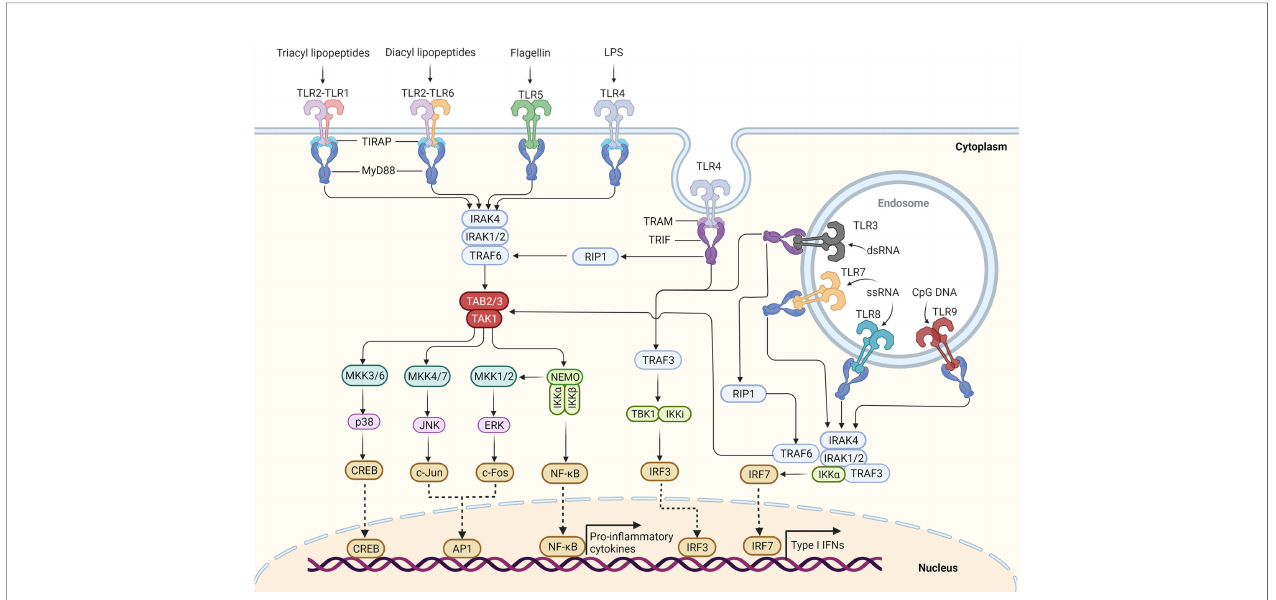
FIGURE 1 | TLR signaling pathway in innate immune cells. TLR5, TLR4, and the heterodimers of TLR2 – TLR1 or TLR2 – TLR6 prefer to recognize the membrane components of pathogens at the cell surface, whereas TLR3, TLR7 – TLR8, and TLR9 localize to the endosomes, where they recognize the nucleic acids from both the host and foreign microorganisms. TLR4 localizes at the plasma membrane, but it is endocytosed into endosomes upon activation. Upon binding to their respective ligands, TLR signaling is initiated by dimerization of receptors, leading to the engagement of TIR domains of TLRs with TIRAP and MyD88 (or directly interact with MyD88) or with TRAM and TRIF (or directly interact with TRIF). The TLR4 signaling switches from MyD88 to TRIF once TLR4 moves to the endosomes. Engagement of MyD88 recruits the downstream signaling molecules to form Myddosome, which is based on MyD88 and contains IRAK4 and IRAK1/2. IRAK1 further activates the E3 ubiquitin ligase-TRAF6 to synthesize the K63-linked polyubiquitin chains, leading to the recruitment and activation of the TAK1 complex. The activated TAK1 further phosphorylates and activates the canonical IKK complex, ultimately leading to the activation factor NF- k B. The activation of TAK1 also leads to the activation of MAPKs, including MKK4/7 and MKK3/6, which further activate JNK and p38, respectively. The activation of IKK b also leads to the activation of MKK1 and MKK2, which further activate ERK1/2. The activation of these MAPKs leads to some important transcription factor activations, such as CREB, AP1. These transcription factors cooperate with NF- k B to promote the induction of pro-in fl ammatory cytokines. Engagement of TRIF recruits the TRAF6 and TRAF3. Activated TRAF6 can recruit the kinase RIP1 and activate the TAK1 complex and IKK complex, leading to the activation of NF- k B and MAPKs. TRIF also promotes the TRAF3-dependent activation of the TBK1 and IKK ϵ (originally IKKi), which further phosphorylates and activates IRF3. Among TLR7, TLR8, and TLR9 signaling in pDCs, IRF7 can bind to the Myddosome and is directly activated by IRAK1 and IKK ϵ . Activation of IRF3 and IRF7 leads to the induction of Type I